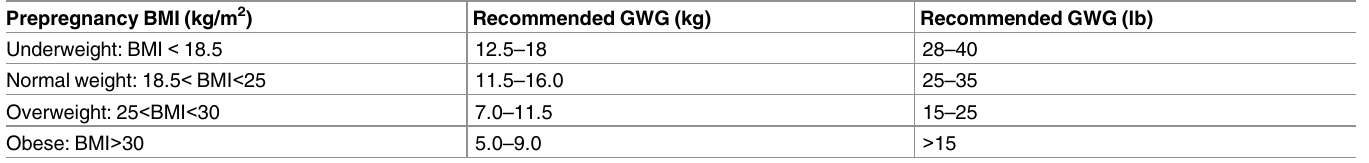
Table 1. Gestational weight gain (GWG) recommendations.